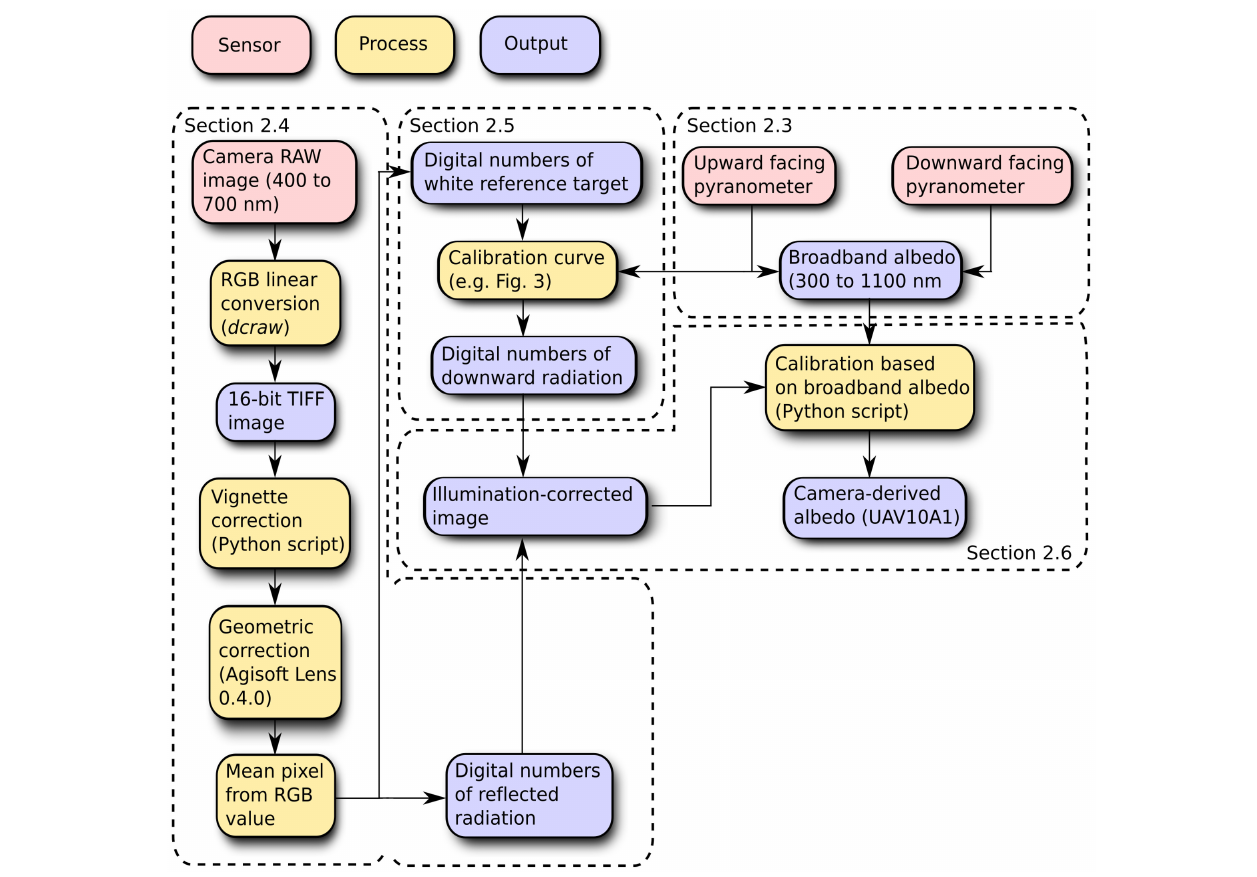
FIGURE 2 | Flow chart showing the procedure to derive albedo from digital camera